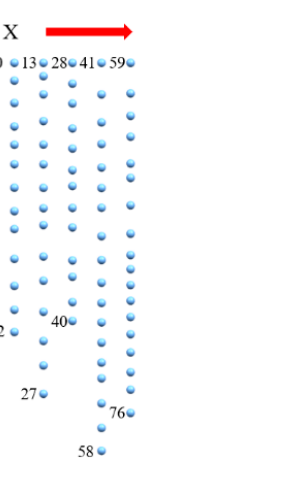
Figure 10. The topological features of the 3D surface PCM labelled with the index numbers .